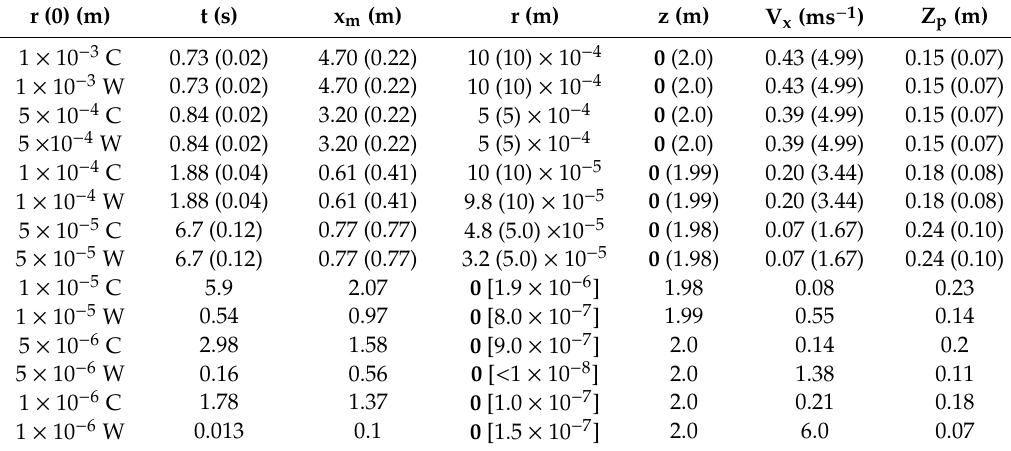
Table 1. The main parameters of the drop-pu ff dynamics, until the maximum horizontal range of contamination was reached by either fallout or evaporation, as indicated by a 0 (in bold) in the z and r columns, respectively. From left to right: the initial drop radius (r(0)); elapsed time (t); contamination range (x m ) at time t; radius (r) at time t; height above ground (z) at time t; pu ff horizontal speed (V x ) at time t; and height (Z p ) reached by the pu ff (entrainment + buoyancy) at time t, with respect to the emission level. Brackets indicate the values at the intermediate exit time, in case of a falling droplet leaving the pu ff (note that the drop can leave the pu ff vertically or horizontally according to its speed and the pu ff size and speed). Square brackets in the r column indicate the actual value of the final radius for evaporating droplets. The droplet height (z) is measured with respect to the ground level, while the pu ff maximum height Z p is with respect to the emission level (2 m above the ground). W = warm-dry, and C = cold-humid